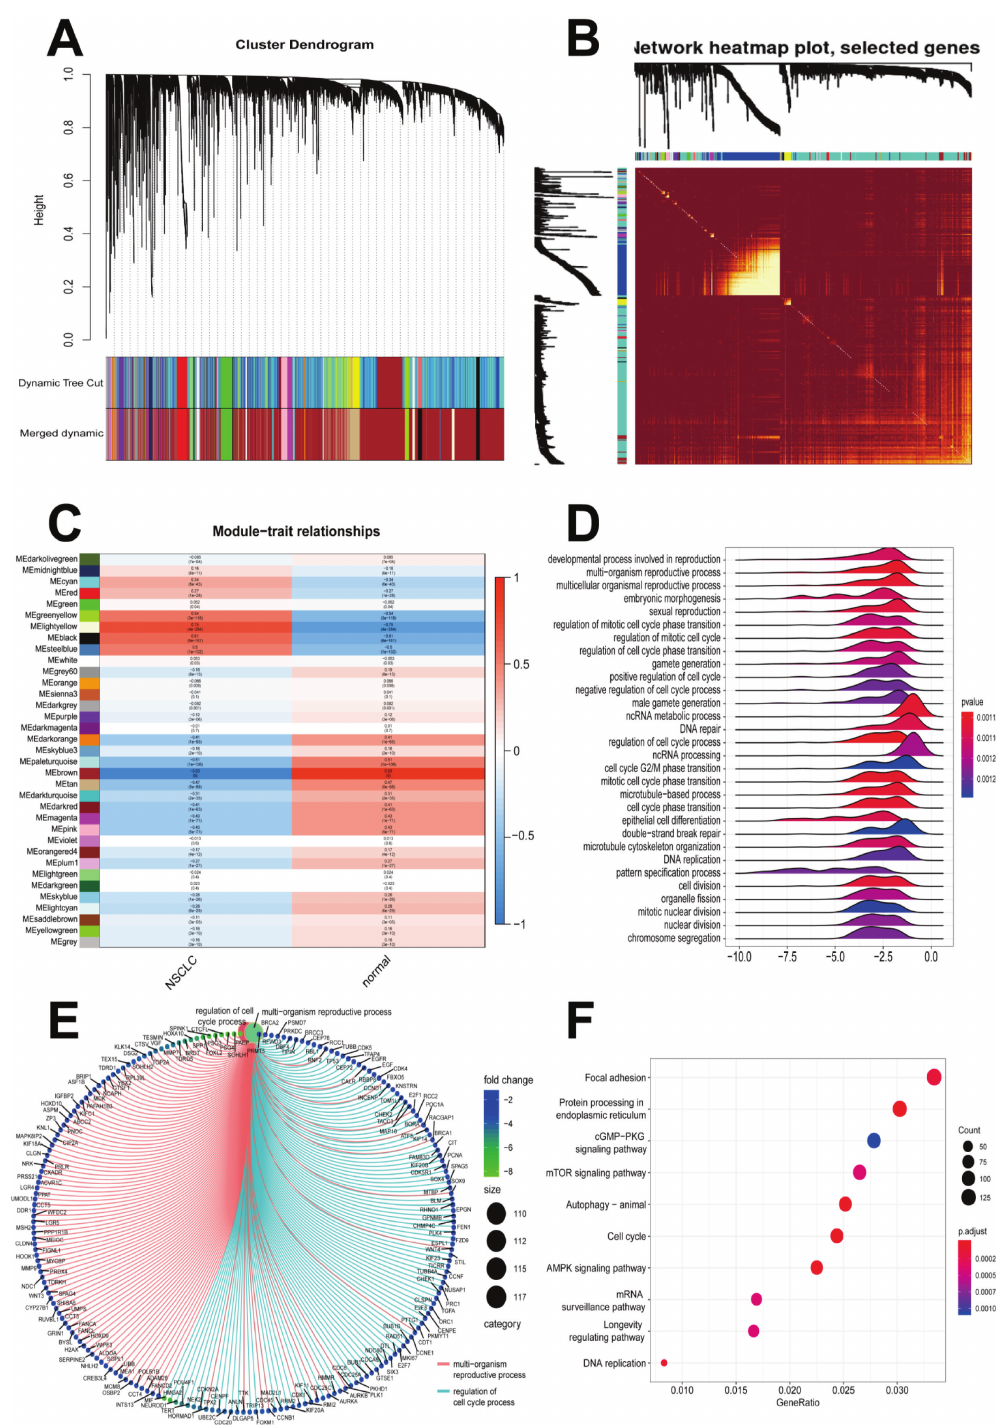
Fig 3. Analysis of mRNA modules by WGCNA. (A) Dendrogram of mRNAs with top 80% variances clustered based on topological overlap. (B) TOM heatmap plot of selected genes. Light colors denote low topological overlap, and dark colors denote high topological overlap. (C) Correlation of gene color modules between NSCLC and normal samples. The ME of the brown module was the most positively related to NSCLC. (D–E) GO-GSEA showing the gene symbols and gene interaction in the brown module. (F) KEGG investigating the signal pathway enrichment in the brown module. WGCNA, weighted gene co-expression network analysis; TOM, topological overlap matrix; NSCLC, non-small cell lung cancer; ME, module eigengene; GO, Gene Ontology; KEGG, Kyoto Encyclopedia of Genes and Genomes pathway analyses; GSEA, Gene Set Enrichment Analysis.